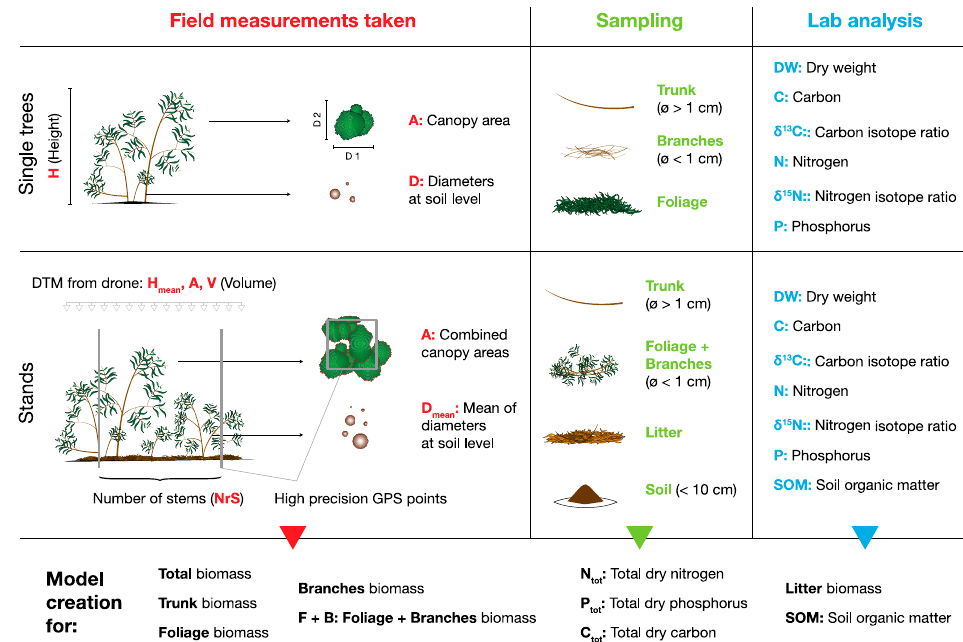
Figure 4. Overview of sampling scheme, summarising field measurements taken, sampled biomass pools and variables measured by lab analysis.